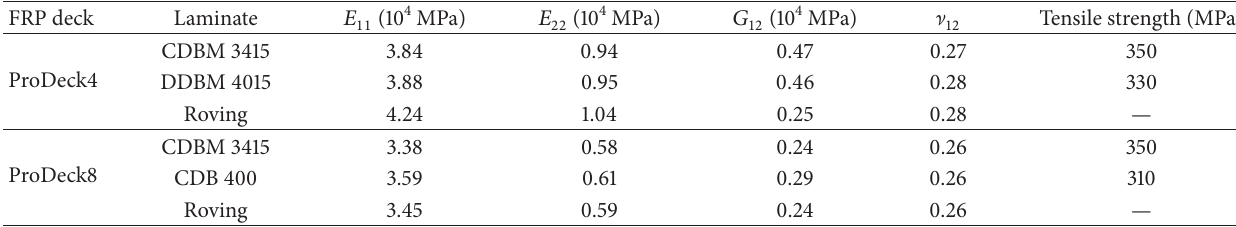
Table 1: Mechanical properties of laminates for ProDeck4 and